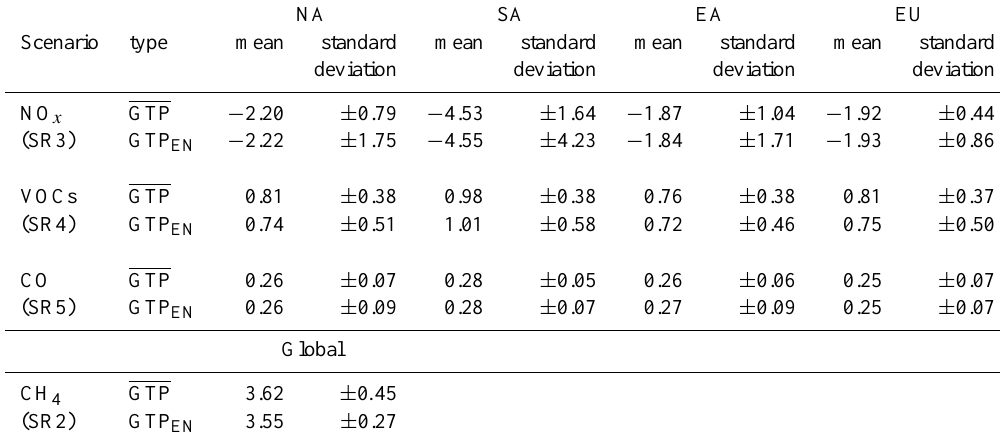
Table 7. As Table 4 for the 100 year